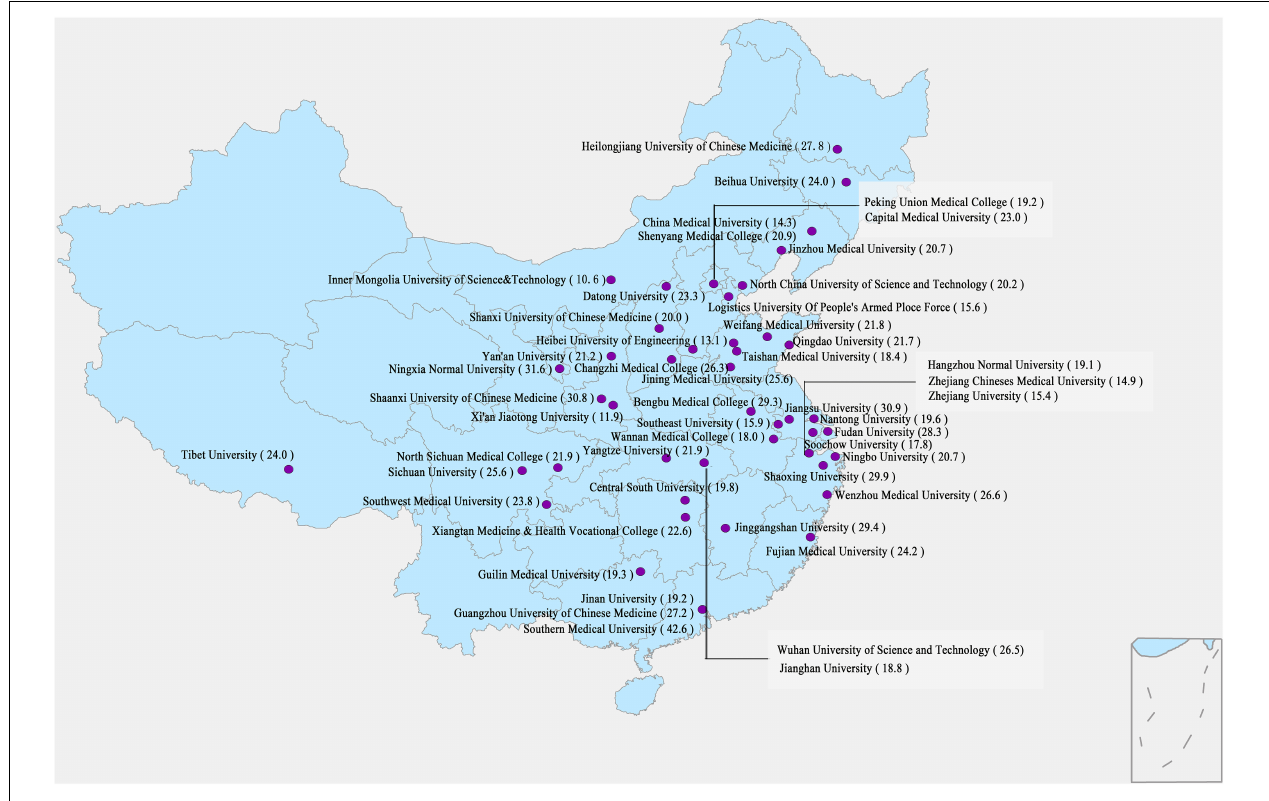
FIGURE 1 | Geographical distribution and the prevalence of mental disorder of the 50 universities across China.